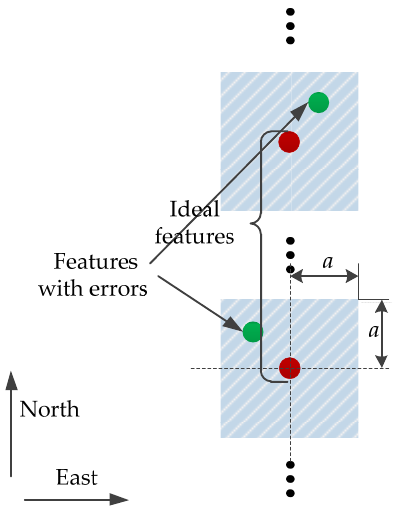
Figure 11. Schematic diagram of feature distribution.